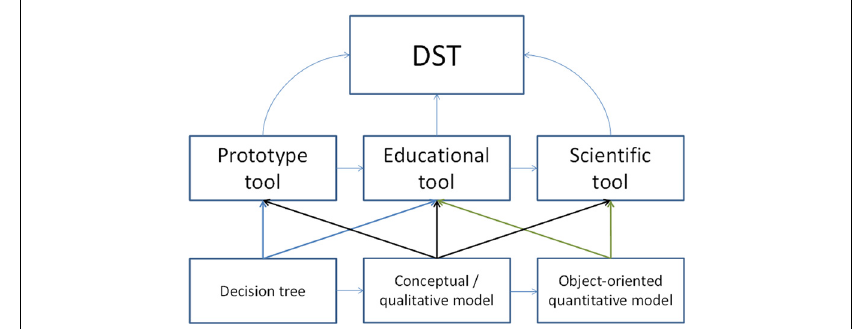
FIGURE 1 | Typology of models used in horticulture. DST, Decision Support Tool. For explanations see